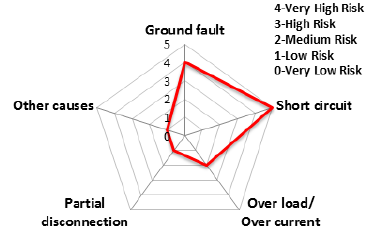
Int. J. Environ. Res. Public Health 2019 , 16 , x Figure 13. The risk rating for electrical fires in Daegu. Figure 13. The risk rating for electrical fires in Daegu. Figure 13. The risk rating for electrical fires in Daegu. Figure 13. The risk rating for electrical fires in Daegu.